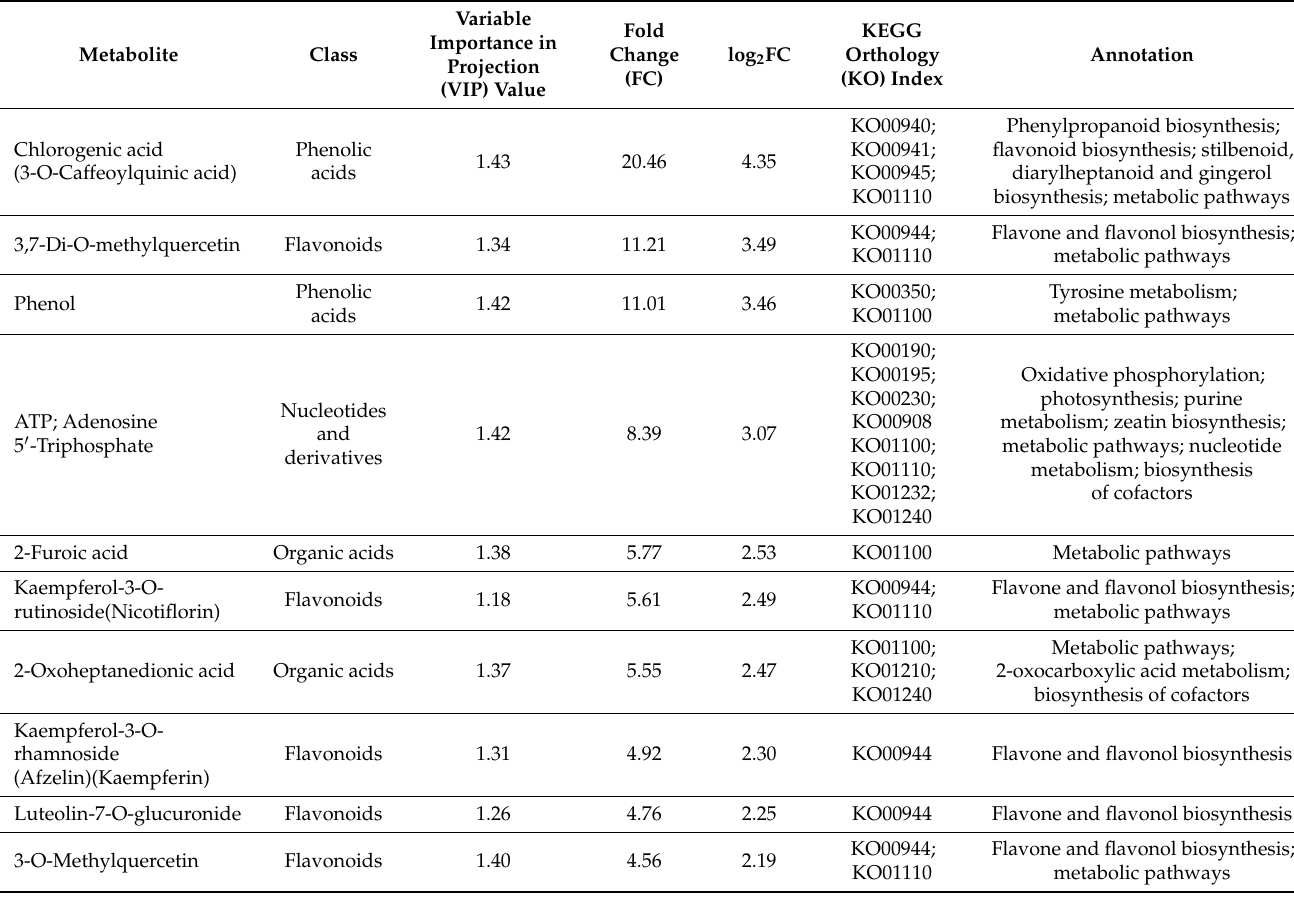
Table 2. Top 10 differentially expressed upregulated metabolites with KEGG database